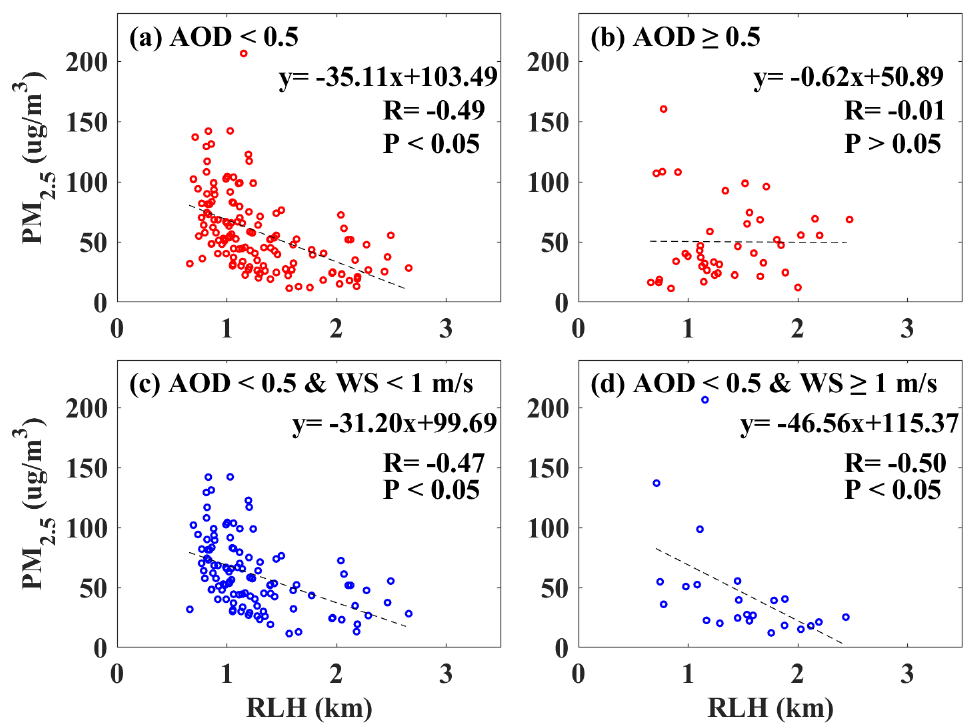
Figure 10. Similar to Figure 9, but for the relationship between the nighttime mean RLH and the average PM 2.5 value on the next daytime.